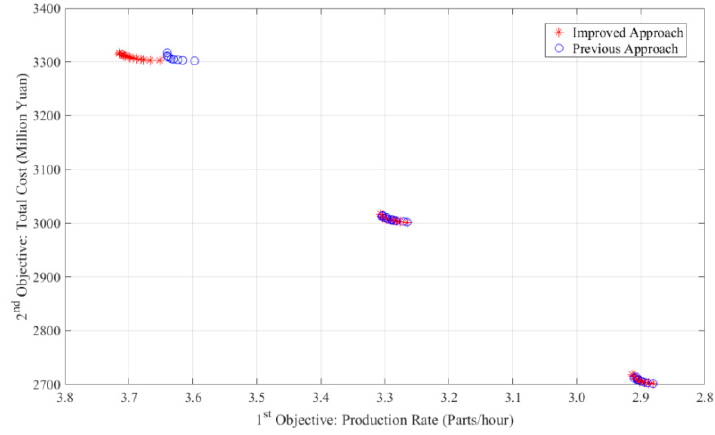
Figure A4. Comparison for Case D: results from the optimal sets of the additional runs.